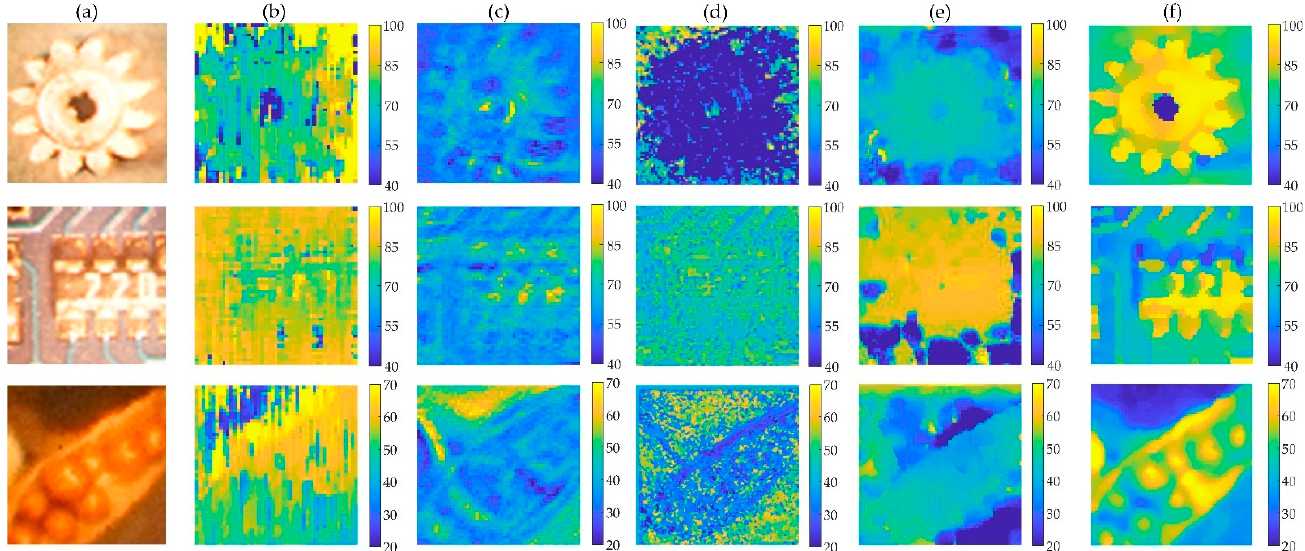
Figure 8. The depth images of three specimen. ( a ) Central directional view image. Depth images generated by ( b ) EPI-ORM [32], ( c ) EPINET [27], ( d ) MANET [38], ( e ) 3D-CNN-LF Depth [39], ( f ) proposed methods, from the same input